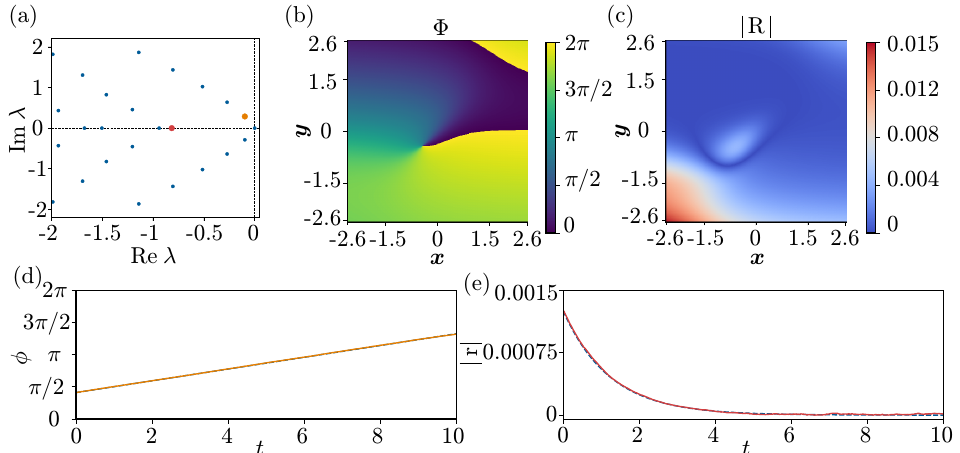
Figure 3. Phase and amplitude functions of a noisy FitzHugh–Nagumo model with parameter set (B). The deterministic vector field does not possess a limit cycle, but regular noise-induced oscillations occur. ( a ) Eigenvalues of L + near the imaginary axis. Orange and red dots represent X Λ Λ Φ . The phase origin is chosen as ( x , p ) = ( 1.5,0 ) . 2 , respectively. ( b ) Phase function 1 and ( c ) Amplitude function | R | . ( d ) Evolution of averaged phase φ . ( e ) Evolution of averaged amplitude | r | . In ( d , e ), averaged results over 10,000 trajectories (orange-thin or red-thin lines) and analytical solutions (blue-dotted lines) are